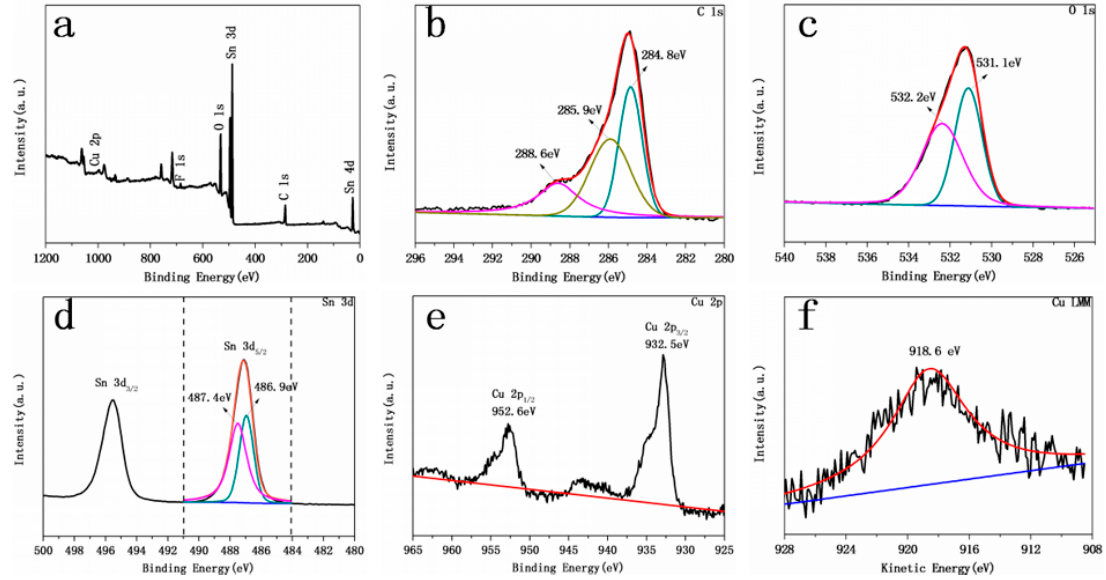
Figure 5. XPS (X-ray photoelectron spectroscopy) spectra of 19.2% Cu/FTO sample. ( a ) Survey spectra; ( b ) C 1s; ( c ) O 1s; ( d ) Sn 3d; ( e ) Cu 2p; and ( f ) Cu 2p AES (Auger electron spectroscopy).